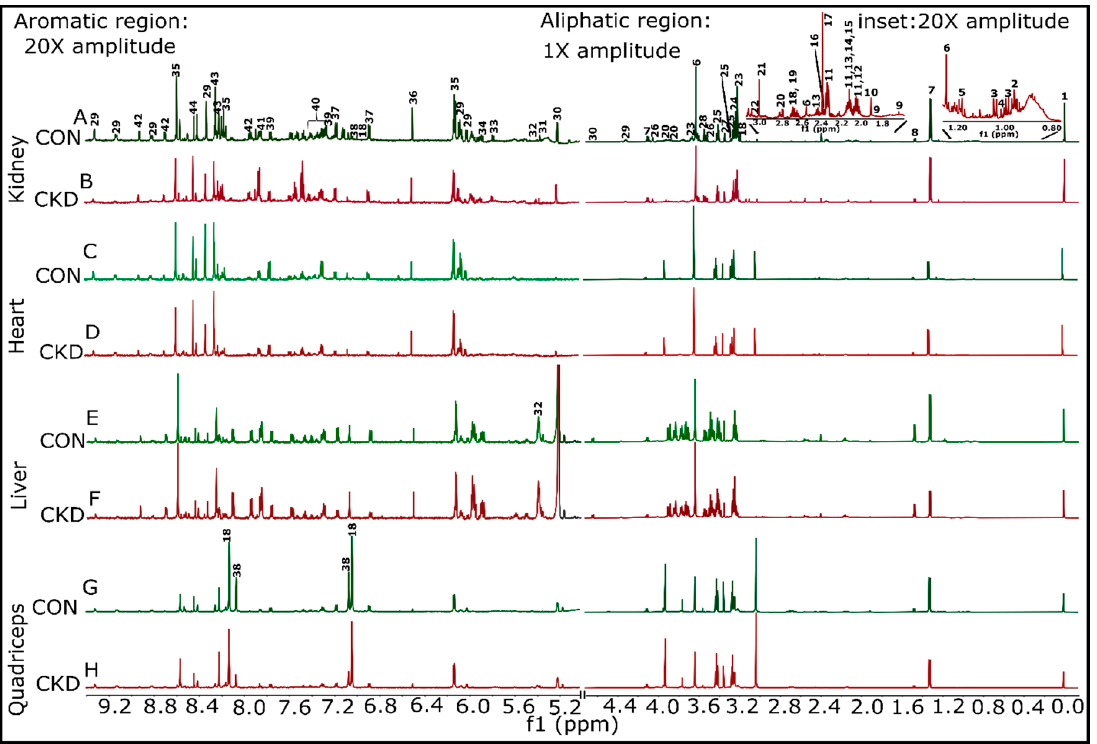
Figure 2. Representative 1 H NMR spectra for the aqueous phase samples from both control and CKD groups were shown for kidney, heart, liver, and quadriceps muscle. Samples having almost equal wet weigh for both control and CKD groups within a particular tissue sample were selected so that the comparisons become legitimate. (A,B) Kidney control#5 (12.3 mg) and CKD#5 (12.5 mg), respectively. (C,D) Heart control#5 (6.8 mg) and CKD#5 (6.8 mg), respectively. (E,F) Liver